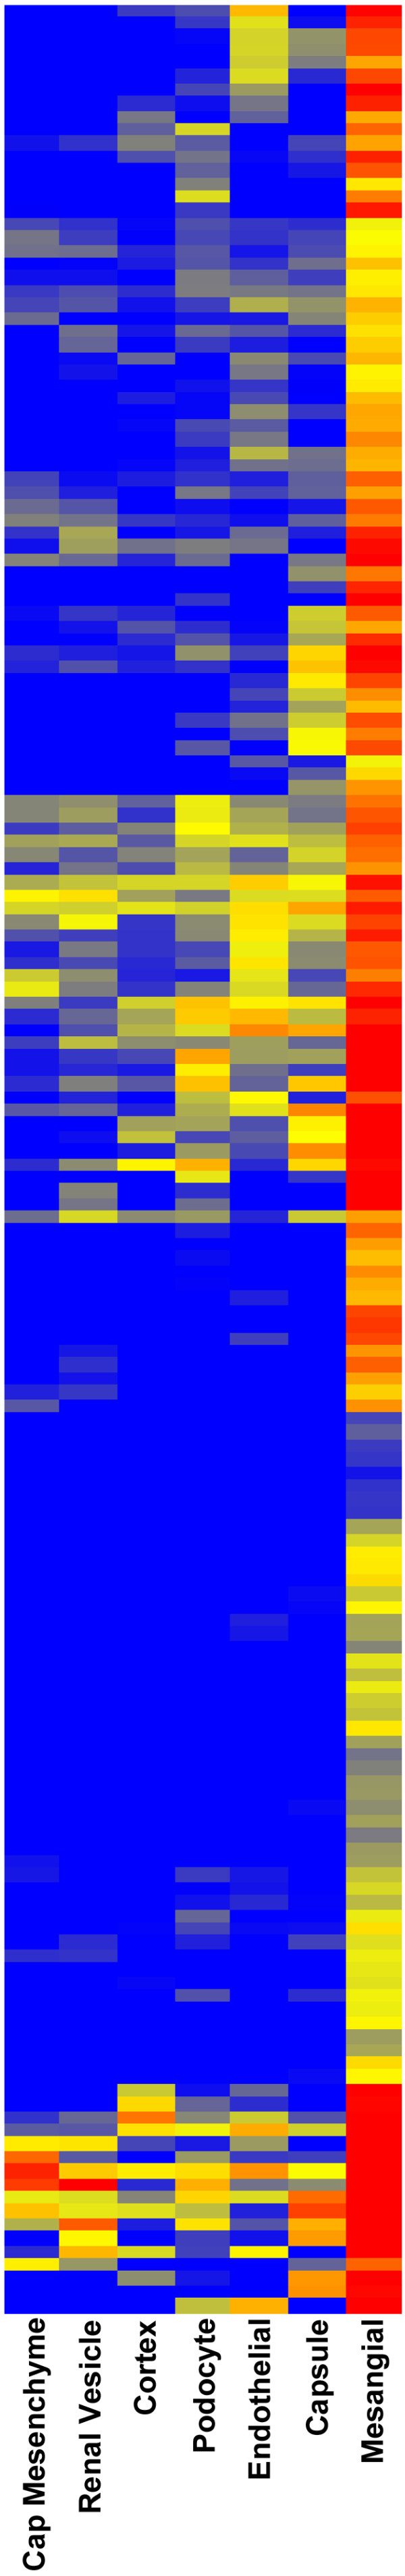
Heatmap showing genes with elevated expression in normal mesangial cells. Expression patterns of 172 genes with up-regulation in mesangial cells are compared across multiple renal compartments, including cap mesenchyme, renal vesicle, total renal cortex, podocytes, endothelial cells and renal capsule. Red indicates high, yellow represents intermediate and blue indicates low gene expression level. Most of the 172 genes are not uniquely expressed in mesangial cells, but do show significantly elevated mesangial expression. For an image that can be zoomed to visualize gene names see Additional file 2: Figure S1.